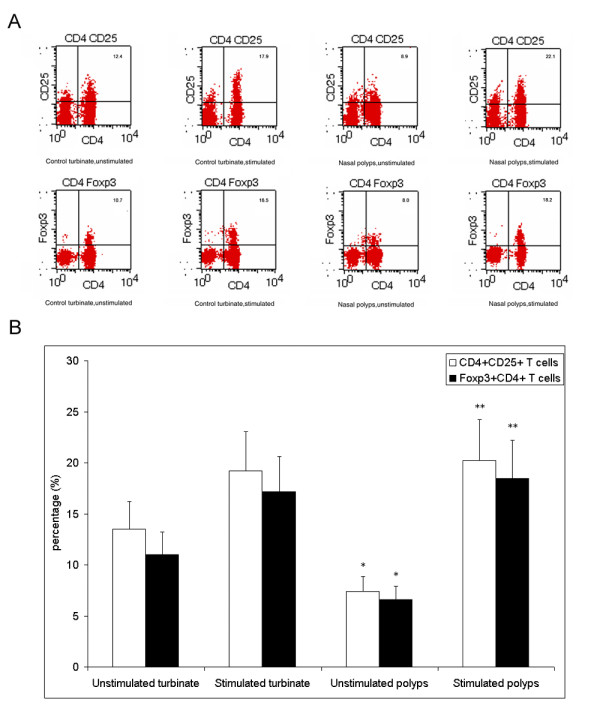
Rapamycin increases the percentages of Tregs in cultured nasal polyps analyzed by flow cytometry. Representative two-dimension scatter diagrams of CD4, CD25, and Foxp3 are shown (A) and we found that rapamycin treatment is associated with an increase in Foxp3+ Tregs in cultured nasal polyps(B). Significant changes in CD4+CD25+ and Foxp3+CD4+ cells were observed during multiple comparisons (P < 0.0125 by the ANOVA test and Bonferroni correction). The percentages of CD4+CD25+ and Foxp3+CD4+ cells significantly were decreased in nasal polyps, compared to the control (Figure 3) (*P < 0.05 by the unpaired t-test for intergroup comparison). After treatment with rapamycin, a significant increase in the frequencies of CD4+CD25+ cells and Foxp3+CD4+ Tregs was found in nasal polyps (**P < 0.05 by the paired t-test for intragroup comparison).